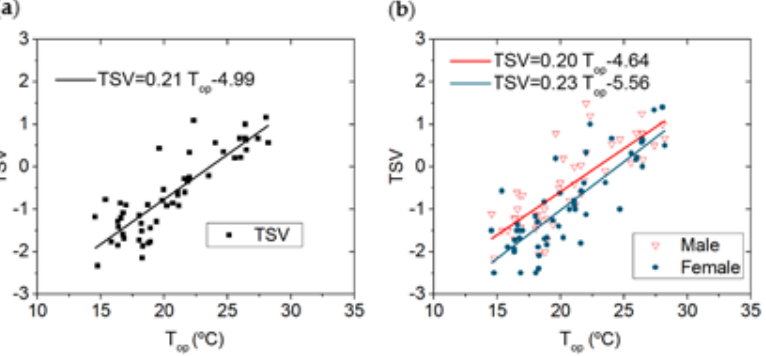
Figure 7. ( a ) TSV values reported by students versus T op ; ( b ) values of TSV reported by female and male students versus T op . Table 6. Fitting equations of TSV against t op .